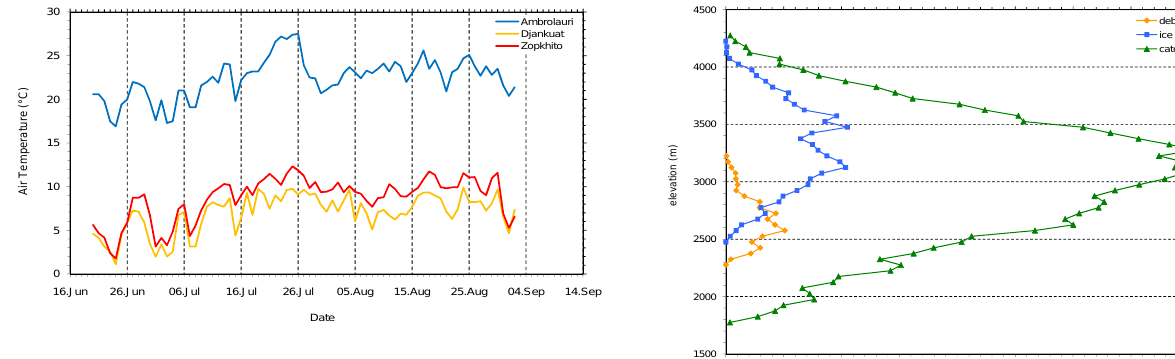
during summer due to the advection of humid air from the Black Sea generating the observed precipitation events. A